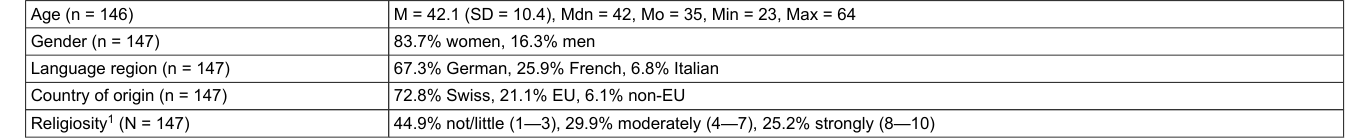
Table 1: Socio-demographic characteristics. Age (n = 146) Gender (n =